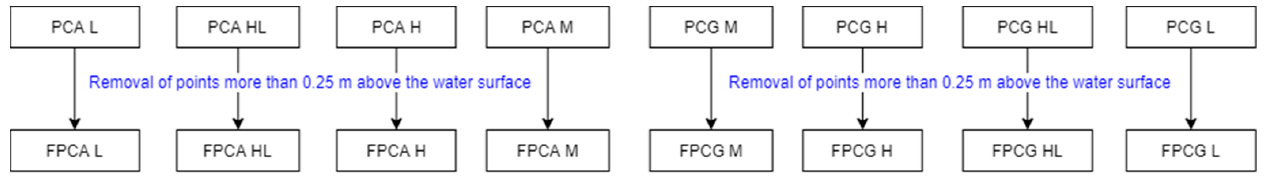
Figure 14. Schematic of the process of removing points more than 0.25 m above the water surface.